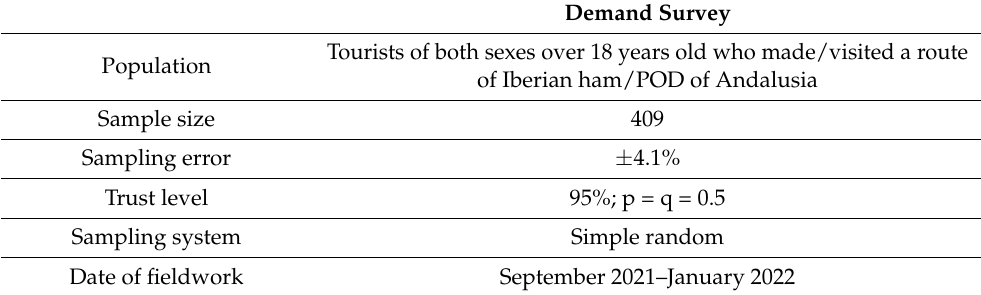
Table 2. Survey data